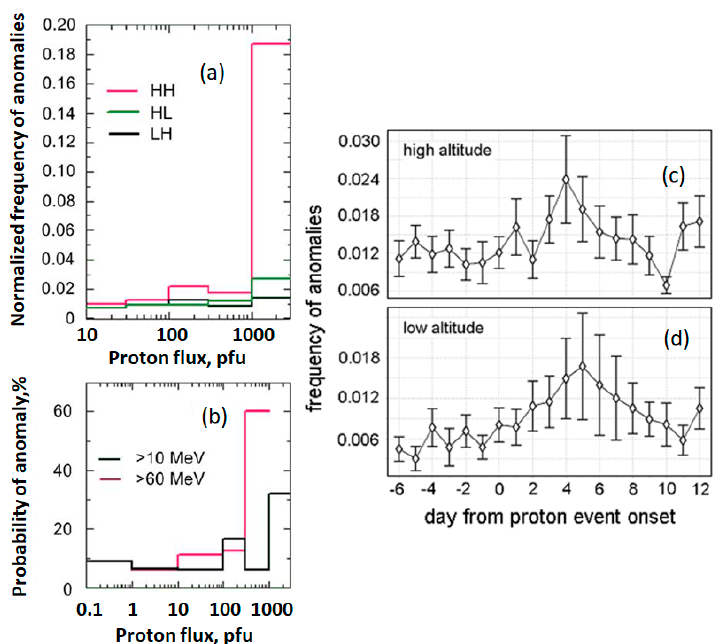
Figure 17. ( a ) The normalized frequency of spacecraft anomalies (averaged over the first 2 days of proton enhancements) as a function of maximal proton flux at energies >10 MeV from IMP8 for various Earth orbits: high altitude with high inclination (HH, red), high altitude with low inclination (HL, green), and low altitude with high inclination (LH, black). ( b ) The probability of anomaly as a function of proton flux in two different energy channels (>10 MeV in black and >60 MeV in red). Particle data in ( a , b ) are from IMP 8. The frequency of anomalies as a function of time elapsed since the onset of a proton event for high-altitude ( c ) and low-altitude ( d ) spacecraft, irrespective of inclination (adapted from [161]).